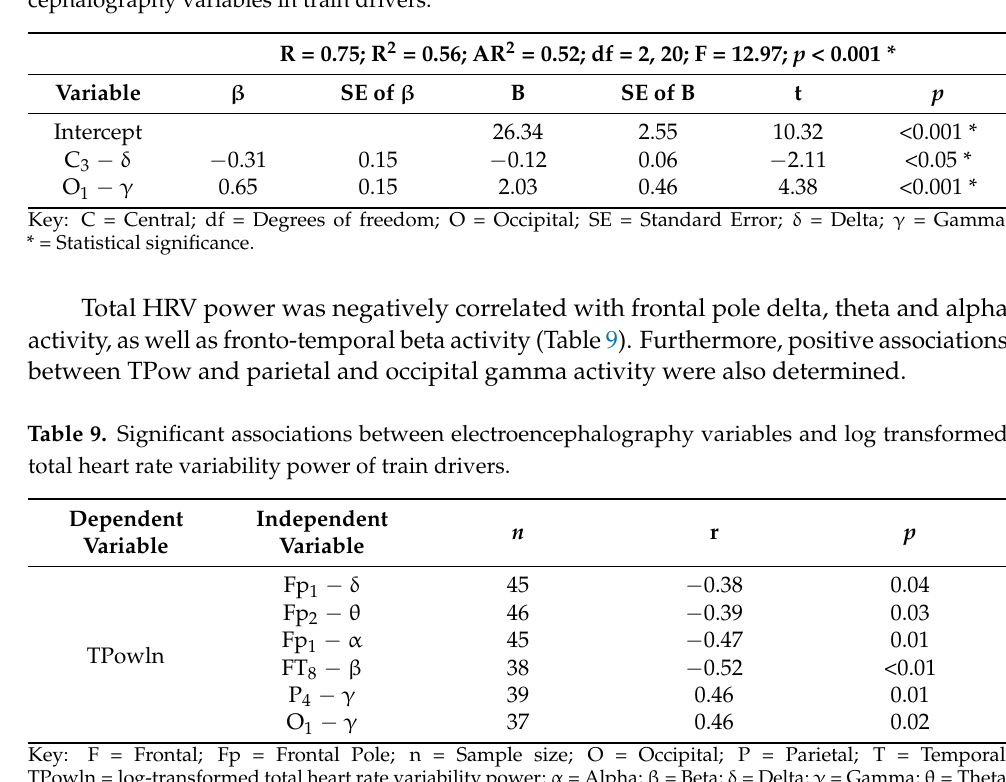
Table 8. Regression analysis for normalised high frequency heart rate variability and electroen- cephalography variables in train drivers.